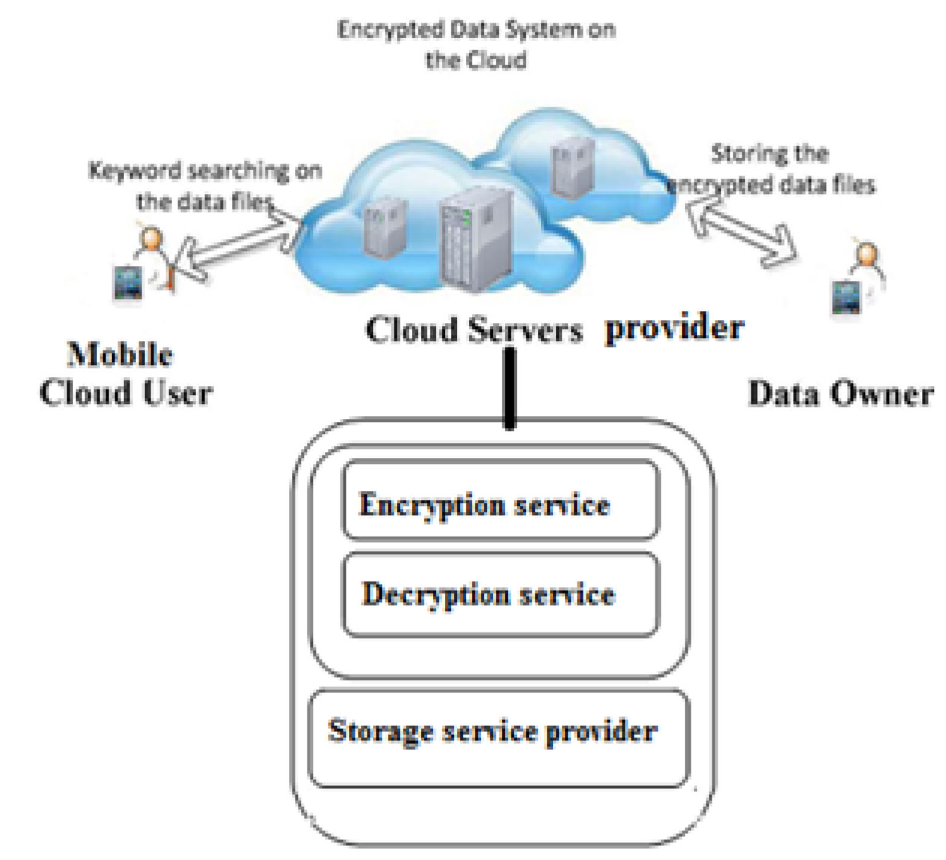
Fig. 8 Overview of the secure mobile cloud service architecture